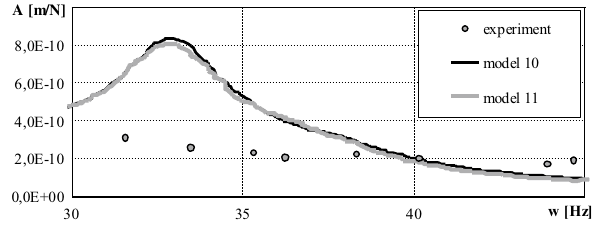
Fig. 11 Dependences of the displacement amplitudes of the forced oscillations of the support No. 4 on the frequencies for models 10 (basic) and 11 (basic with a high degree of